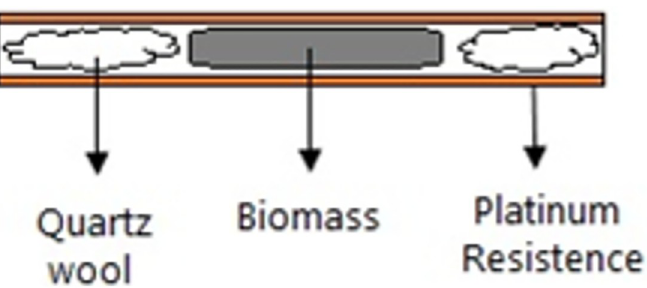
Fig 1. Scheme of quartz capillary with quartz wool and biomass placed in the micropyrolyzer (Adapted from Sim ã o et al . [11]).